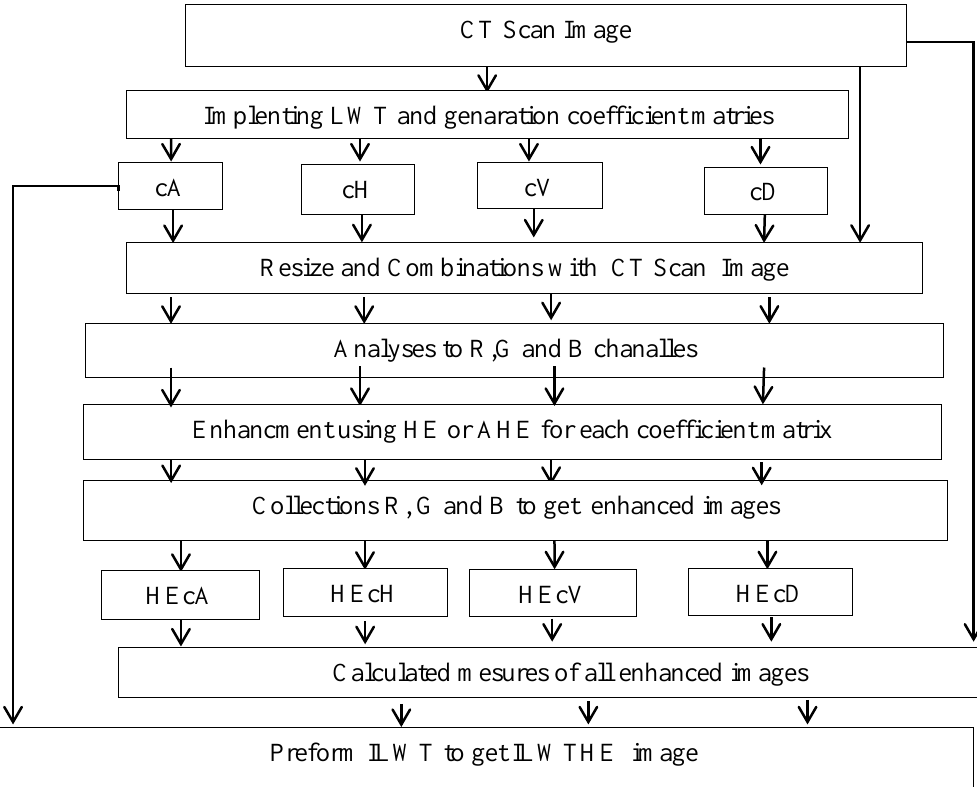
Fig.3: Flow chart of the proposed